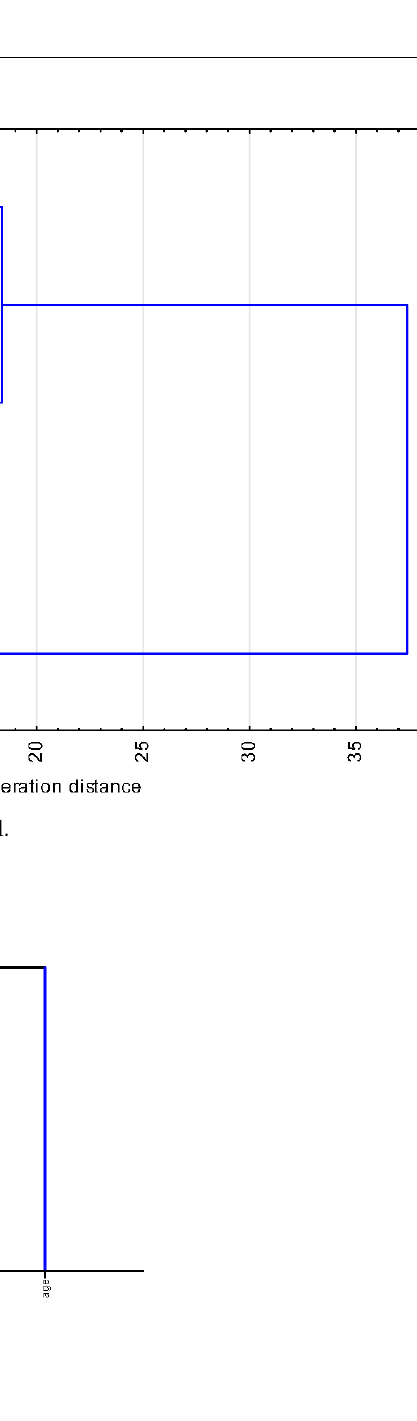
Figure 4. Analysis of hierarchical clusters.